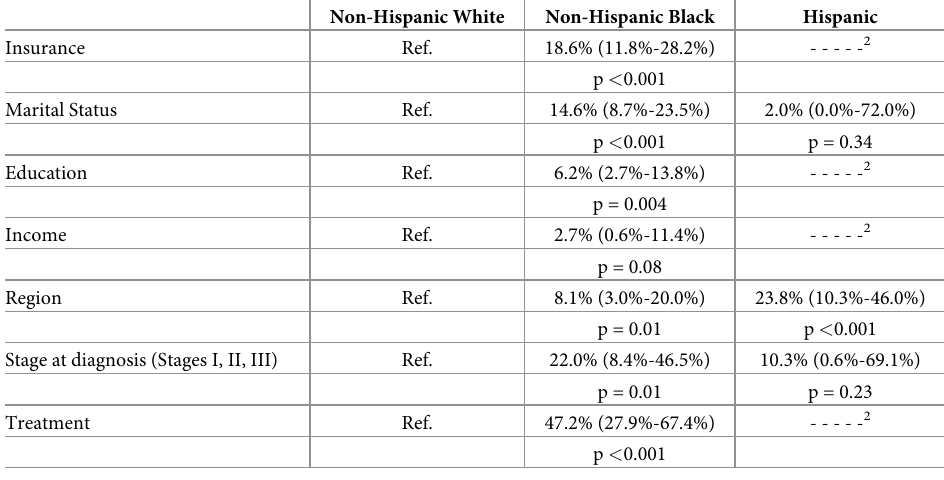
Table 3. Proportion mediated 1 of the association between race and cervical cancer mortality by socioeconomic and clinical variables, among women diagnosed with stages I-III disease in SEER 2007–2013 (cid:3)